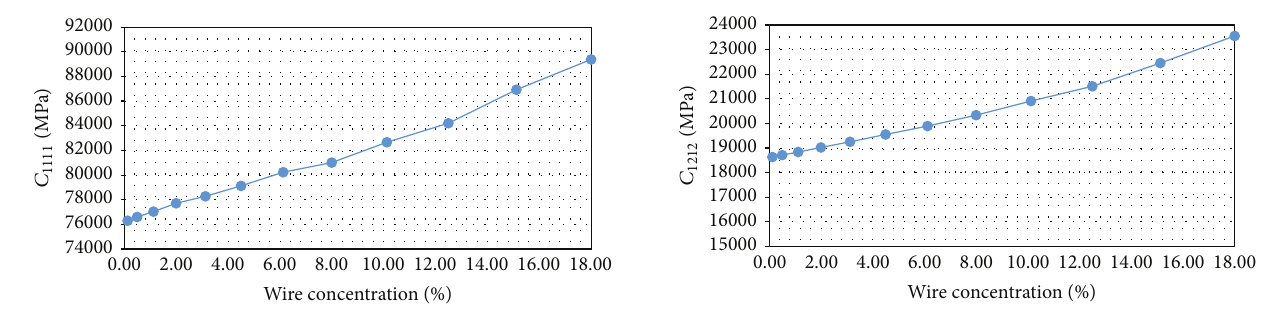
(0) 𝐶 1212 for reinforced plexiglas